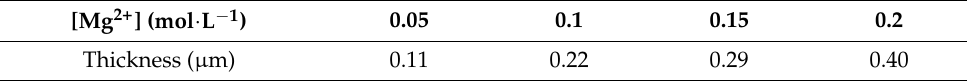
Figure 7. Variation in the refractive index (n) for MgO layers synthesized by spray for [Mg 2+ ] = 0.05; 0.10; 0.15; and 0.20 mol·L − 1 . Table 3. Film thickness of MgO synthesized with [Mg 2 + ] = 0.05; 0.10; 0.15; and 0.20 mol·L − 1 .